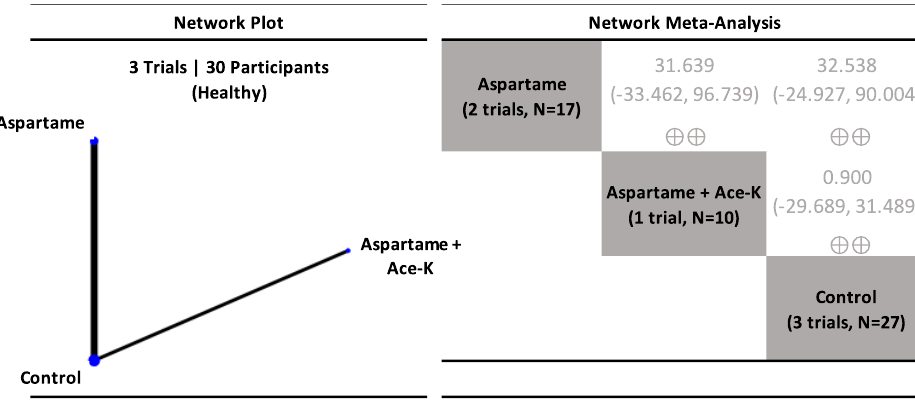
Figure 3. Network plot and meta-analysis of coupling interventions evaluating the effect of non-nutritive sweetened beverages (NNS beverages) sweetened single or blends of non-nutritive sweeteners (NNS) and controls on postprandial glucose response in healthy participants. Network plot: the size of the blue nodes is proportional to the number of participants and the line width is proportional to the number of studies. Network table: treatments are grouped by treatment type (i.e., individual non-nutritive sweeteners (NNS), NNS blends, water, and caloric sweeteners) and are reported in alphabetical order. Treatment estimates (mmol*min/L) are MDs and 95% CIs of the column-defining treatment compared with the row-defining treatment. MDs less than 0 favor the column-defining treatment. MDs greater than 0 favor the row-defining treatment. Significant results are bolded in black. Non-significant results are grey and not bolded. The minimally important difference (MID) for postprandial glucose response is 100 mmol*min/L. Trivial (significant) effects (<1 MID) or no effects have a white background; small important effects ( ≥ 1 MID) have a light blue background; moderate effects ( ≥ 2 MID) have a darker blue background; large effects ( ≥ 5 to <10 MID) have a purple back- ground; and very large effects ( ≥ 10 MID) have a black background. Confidence in the effect estimate is shown for each treatment comparison: high confidence ⊕⊕⊕⊕ ; moderate confidence ⊕⊕⊕ ; low confidence ⊕⊕ ; and very low confidence ⊕ . See Supplementary Table S15 and Figure S34 for detailed assessments of the confidence in the effect estimate using the CINeMA